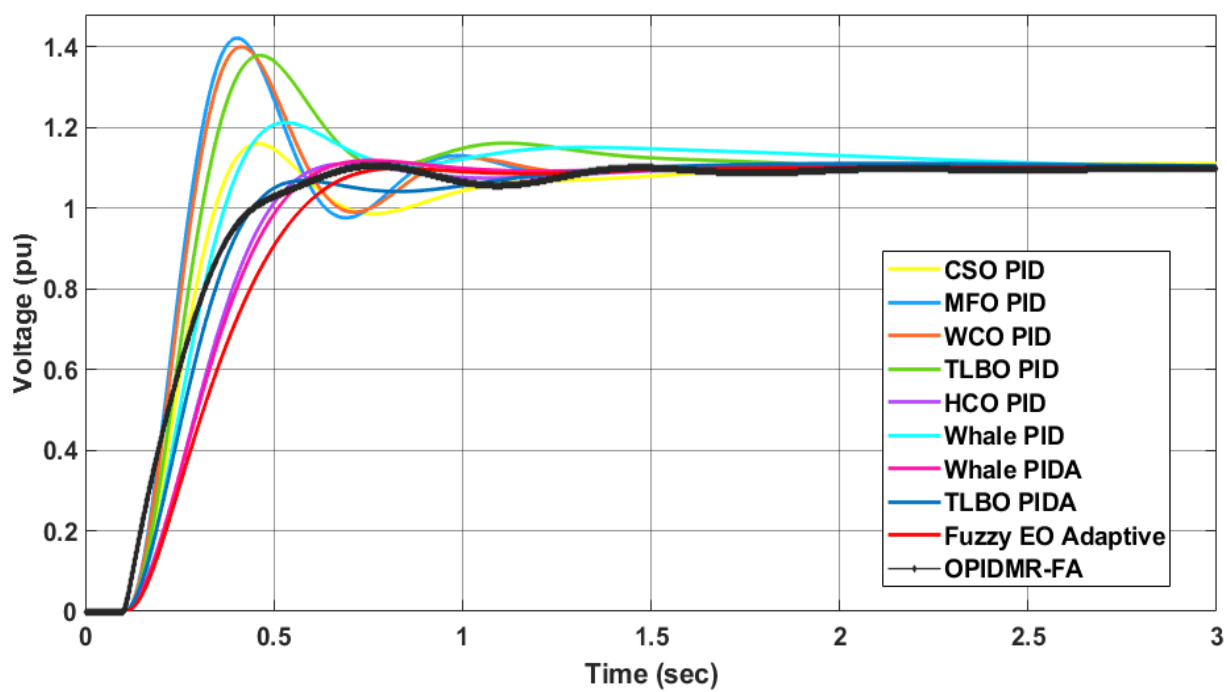
Figure 9. Step-change of 1.1 p.u. on the voltage reference of the AVR model. It is shown that the dynamic response of the proposed OPIDMR-FA had a maximum overshoot that was 9.5% lower than the CSO PID, 38% lower than the MFO PID, 33.33% lower than the WCO PID, 31.4% lower than the TLBO PID, 4.76% lower than the HCO PID, 15.24% lower than the whale PID, and slightly better than the Whale PIDA, TLBO PIDA, and Fuzzy EO